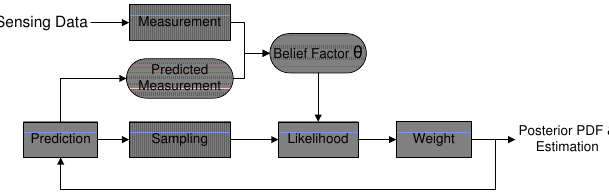
Figure 3. The architecture of the particle filter integrated with the adaptive likelihood method. The common particle filter does not contain the prior measurement and the belief